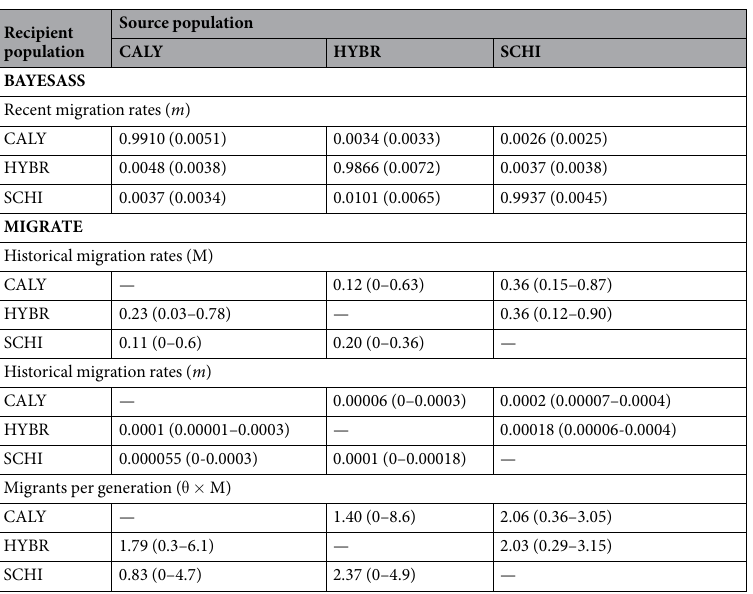
Recipient population